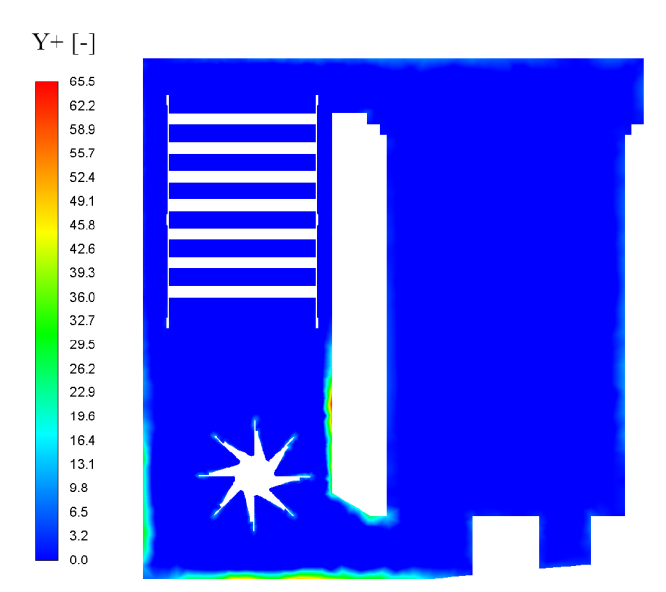
Figure 10. Distribution of Y + on the walls for the baseline operation without the charging basket. The Y + legend applies to the gases.